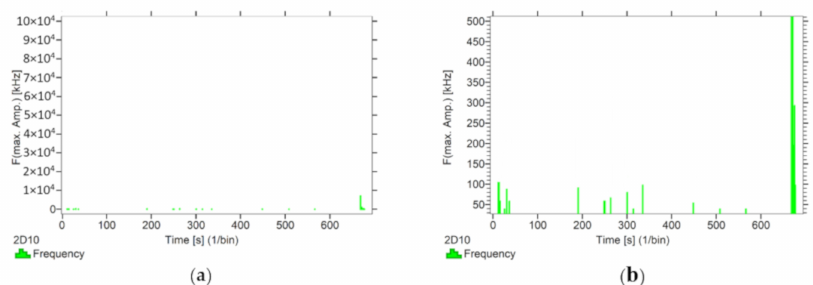
Figure 12. Frequency distribution graph during the test of the mock BC sample: ( a ) taking into account the entire frequency range; ( b ) specifying the frequency range before